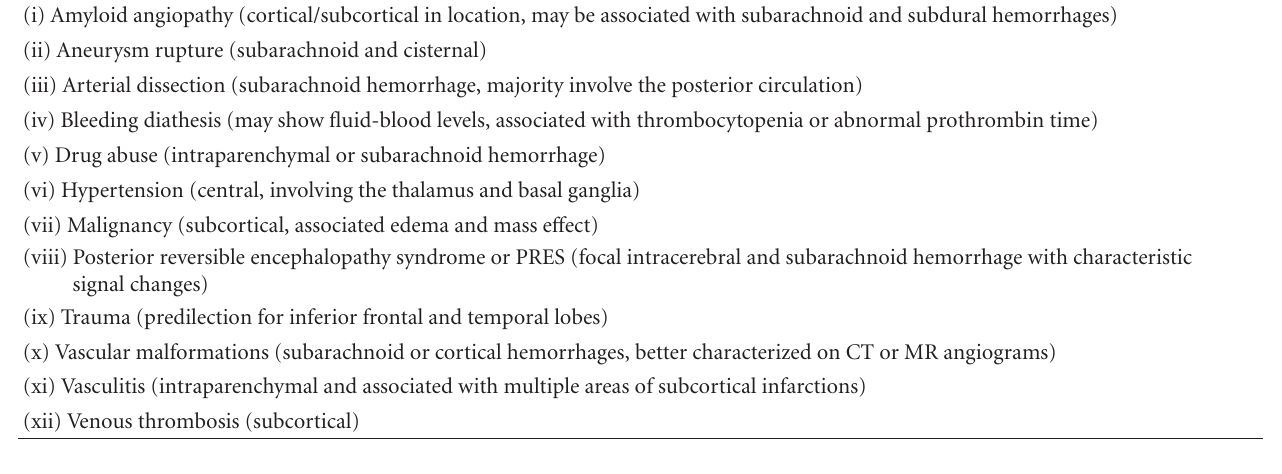
Table 2: Imaging presentations of cerebral amyloidosis [9–12].